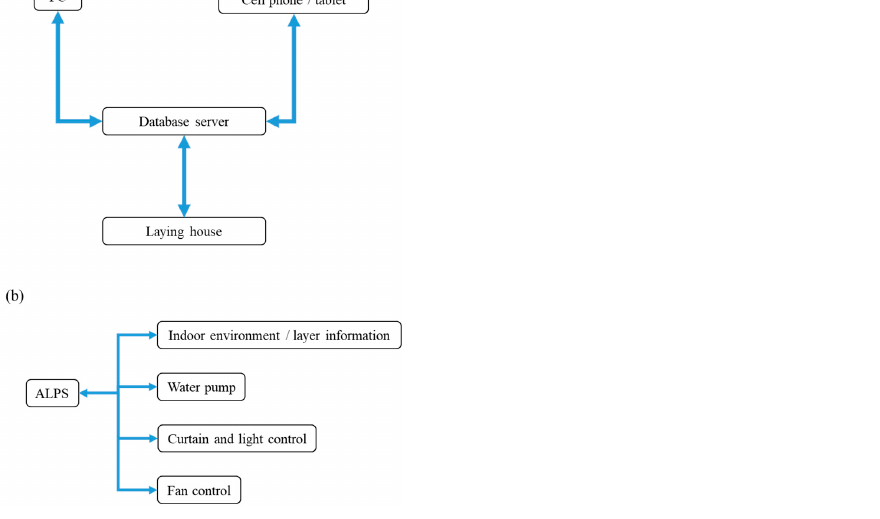
Figure 1. ( a ) Workflow of the Artificial Intelligence Layer Production System (ALPS). ( b ) Operation interface of ALPS.